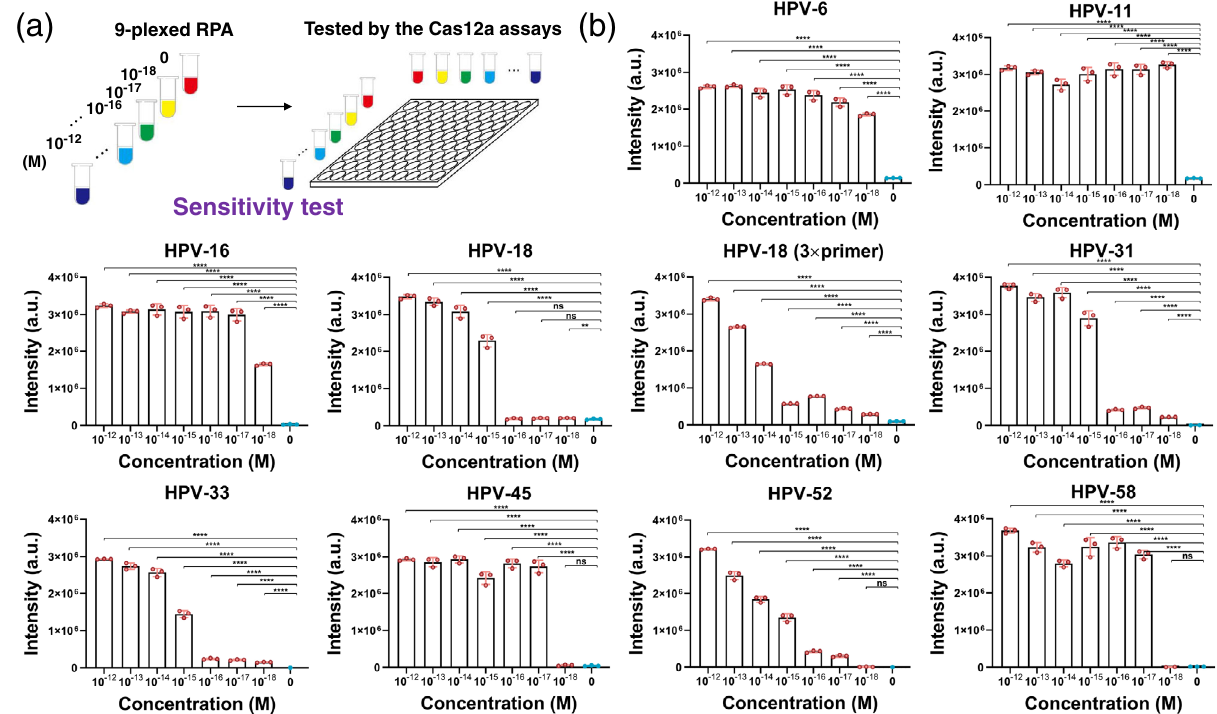
Fig. 4 | Sensitivity test of the 9-plexed RPA assay for the nine HPV subtypes. a Schemeshowingthataseriesofsampleswithdifferentplasmidconcentrationsof the nine targets were prepared, ampli fi ed and tested. b Titration of the plasmids after RPA based on the Cas12a assay. Note that the 9-plexed RPA assay (1× primer foreachtarget)achievedasensitivityof10 − 17 – 10 − 18 MforallthetargetsexceptHPV- 18,whilethe sensitivity for HPV-18couldalso beimproved to 10 − 18 M afterusing 3×